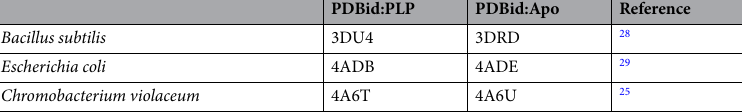
Table 2. Structural similarity search using DALI.